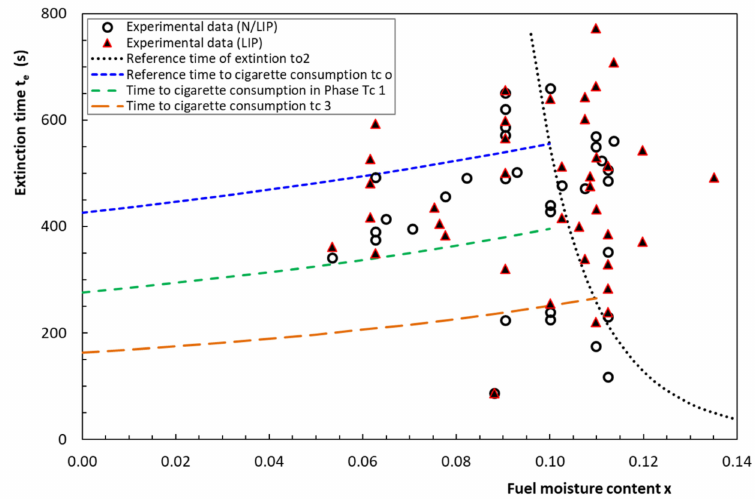
Figure 11. Values of extinction time t e as a function of fuel moisture content x for cigarettes under various test conditions (Series CS1 and CS2). The lines correspond to present model prediction of t oe and burnout times of cigarettes t c .